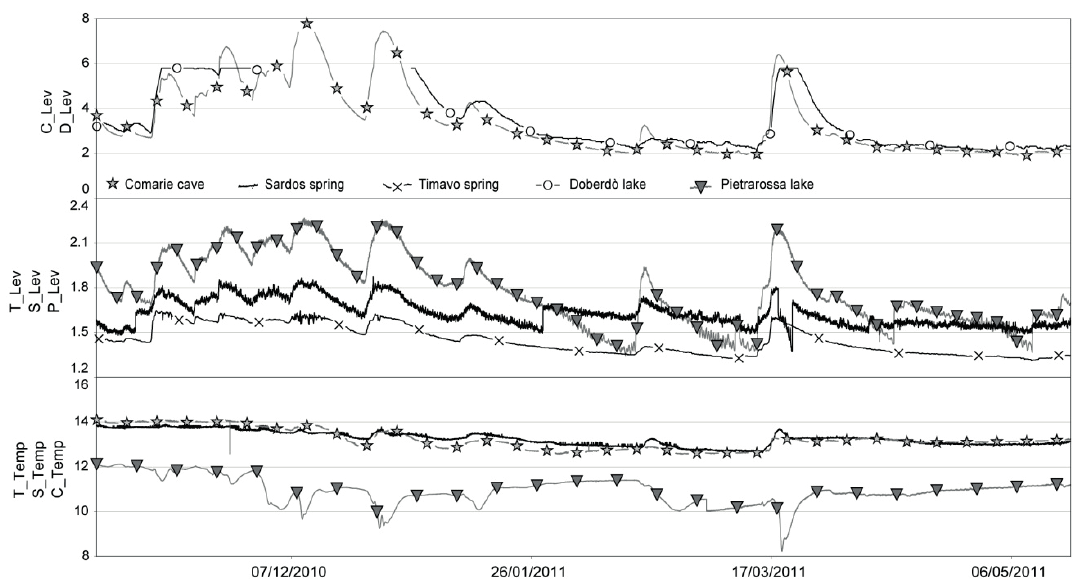
Fig. 4 Water level and temperature parameters recorded (2010–2011) for the Comarie Cave, Sardos and Timavo springs, Doberdò and Pietrarossa